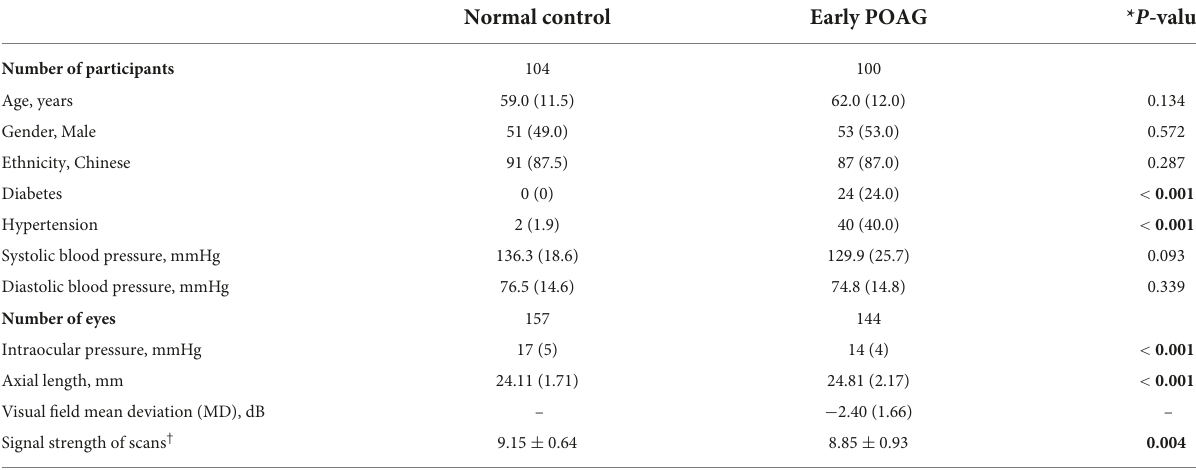
TABLE 1 Comparison of demographics, systemic, and ocular characteristics between normal control and primary open angle glaucoma patients. Normal